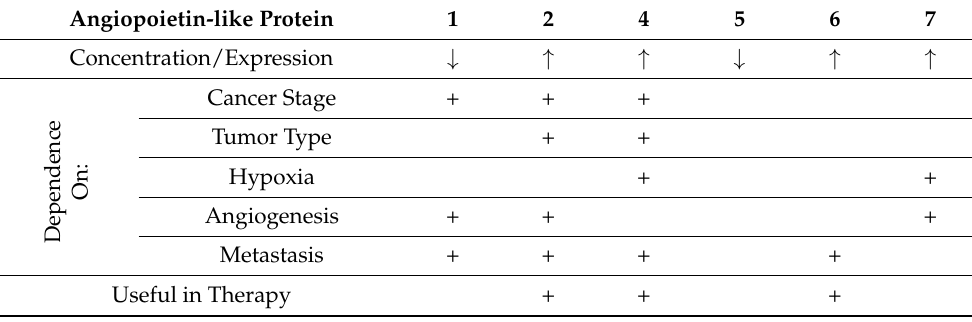
Table 1. Involvement of angiopoietin-like proteins in colorectal